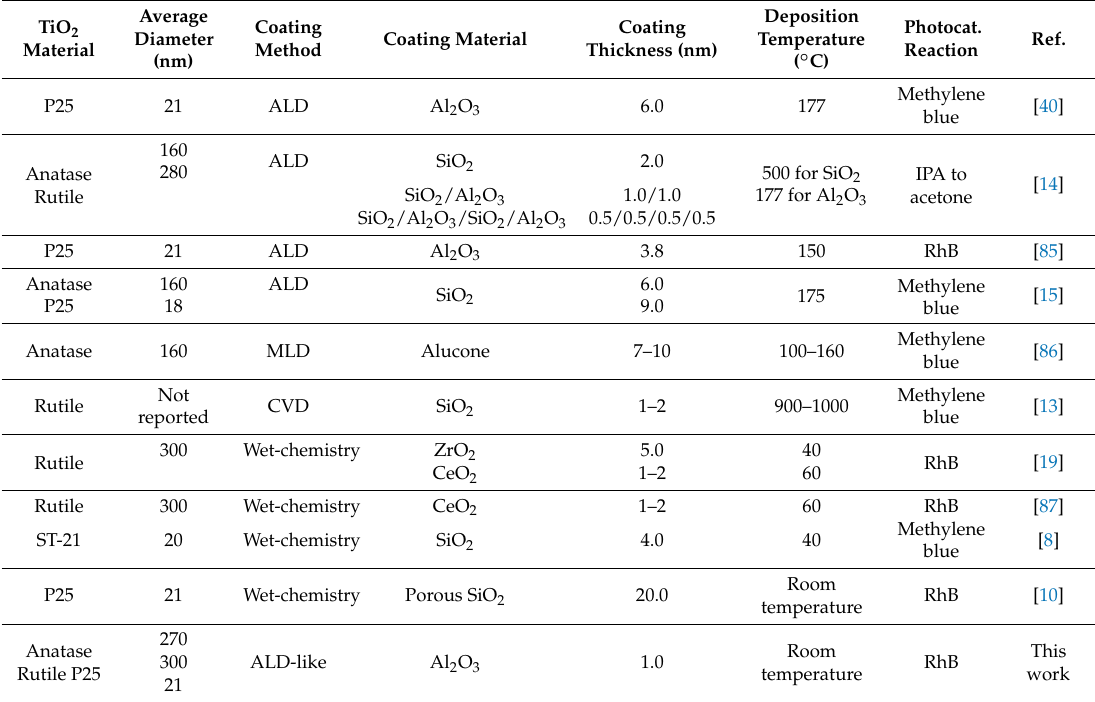
Table 2. Coating methods and materials for suppressing photocatalytic activity of TiO 2